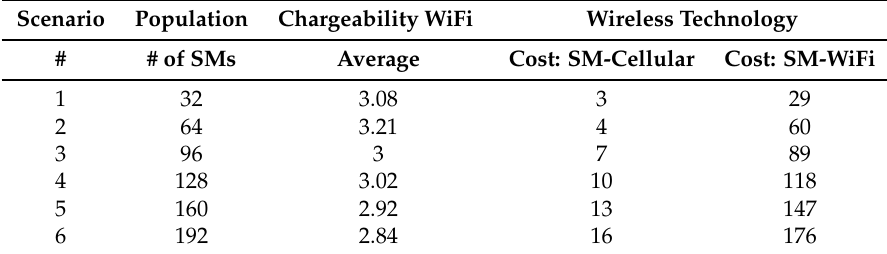
Table 5. Chargeability: cost (SM-cellular and SM-WiFi).